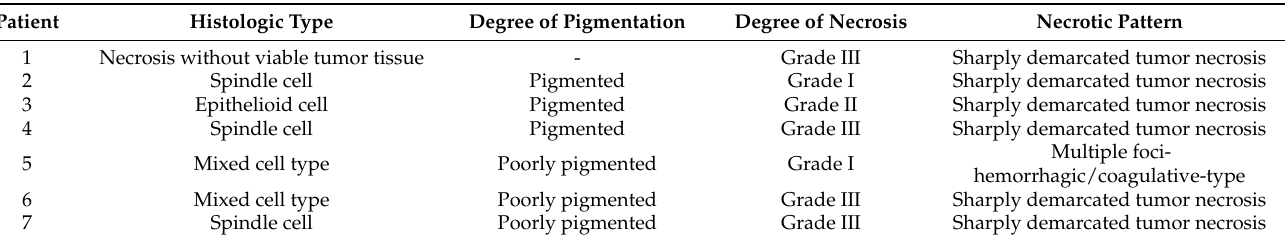
Table 4. Histopathological features of uveal melanomas in the irradiated group.